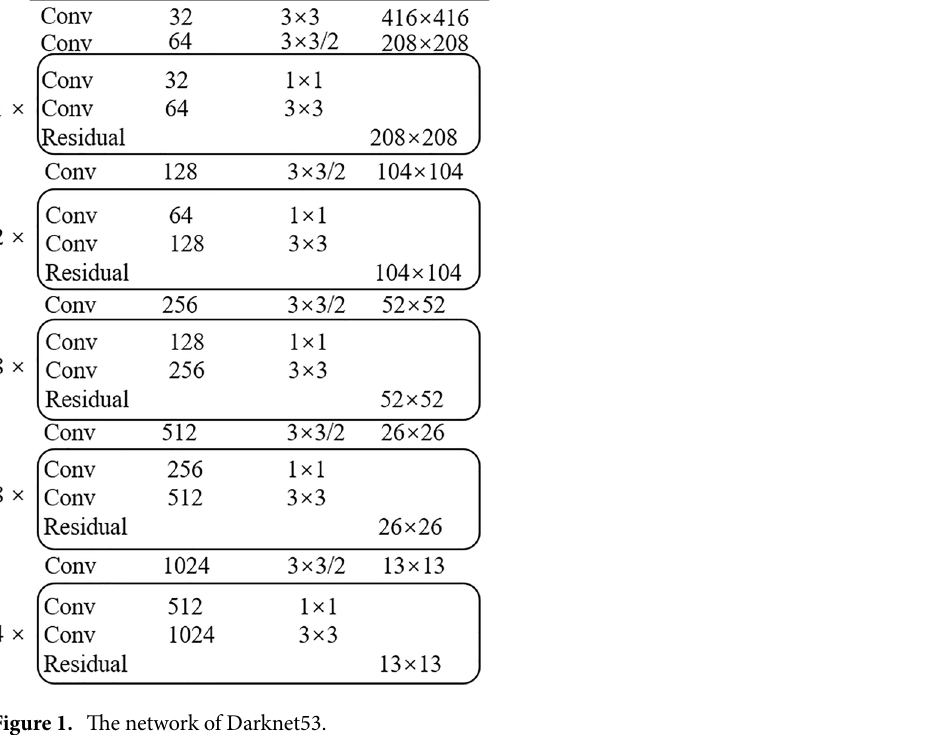
Figure 1. The network of